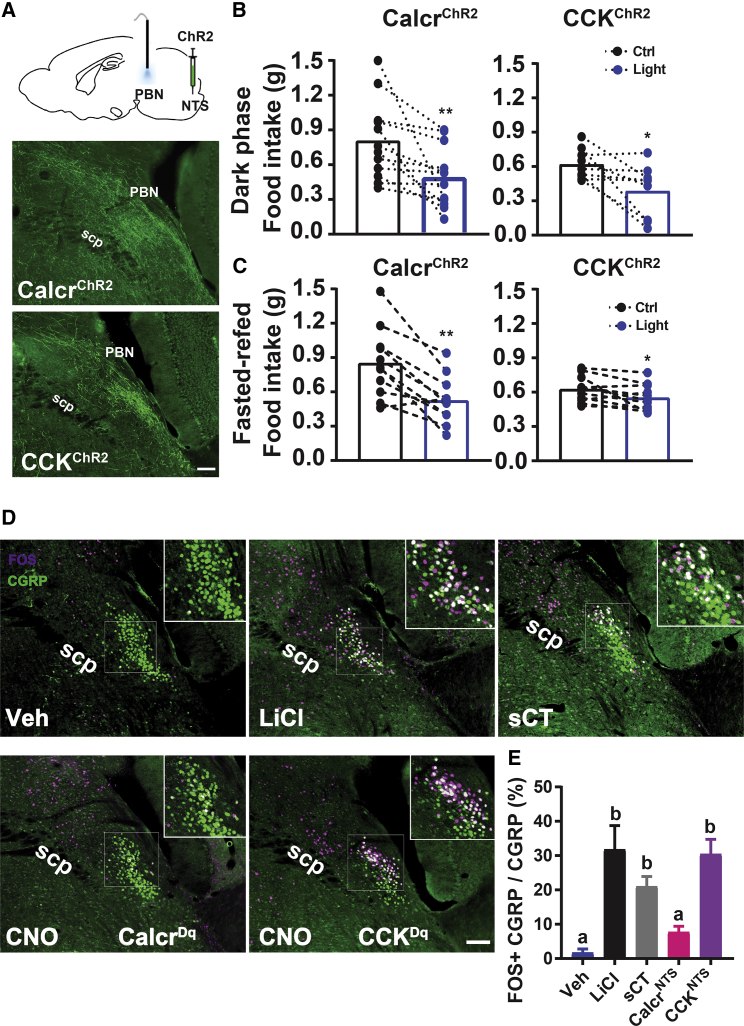
Roles for PBN Projections from CalcrNTS and CCKNTS Neurons(A) Diagram showing experimental setup and images showing ChR2-GFP-containing projections (green) into the PBN of CalcrNTS-ChR2 (CalcrChR2) and CckNTS-ChR2 (CCKChR2) mice. Scale bar, 150 μm; scp, superior cerebellar peduncle.(B and C) Food intake over the first 2 h of the dark cycle (B) or during the first hour following the return of food to overnight-fasted mice (C) under control (Ctrl) or blue-light-stimulated (Light) conditions. Mean ± SEM is shown, paired t test was performed, ∗p < 0.05, ∗∗p < 0.01. Dark cycle: CalcrChR2 n = 12, CCKChR2 n = 9; refeeding: CalcrChR2 n = 12, CCKChR2 n = 11.(D) Representative images of FOS (purple) and CGRP cells (GFP, green) in the PBN of mice on the Calcacre−GFP background 2 h after treatment with vehicle (Veh), sCT (150 μg/kg, IP), LiCl (126 mg/kg, IP), or CNO (1 mg/kg, IP) in CalcrNTS-Dq (CalcrDq) and CckNTS-Dq (CCKDq) mice. Scale bar, 150 μm; scp, superior cerebellar peduncle.(E) Quantification of FOS-positive CGRPPBN neurons from the groups in (D). Mean ± SEM is shown; n = 3 per group. One-way ANOVA, Tukey’s multiple comparisons was performed, different letters indicate differences, p < 0.05.